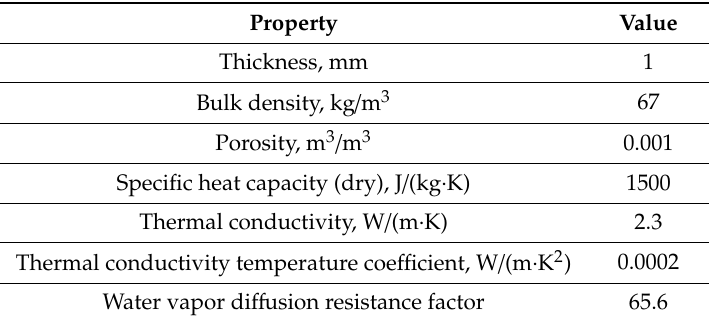
Table A12. SBPC property